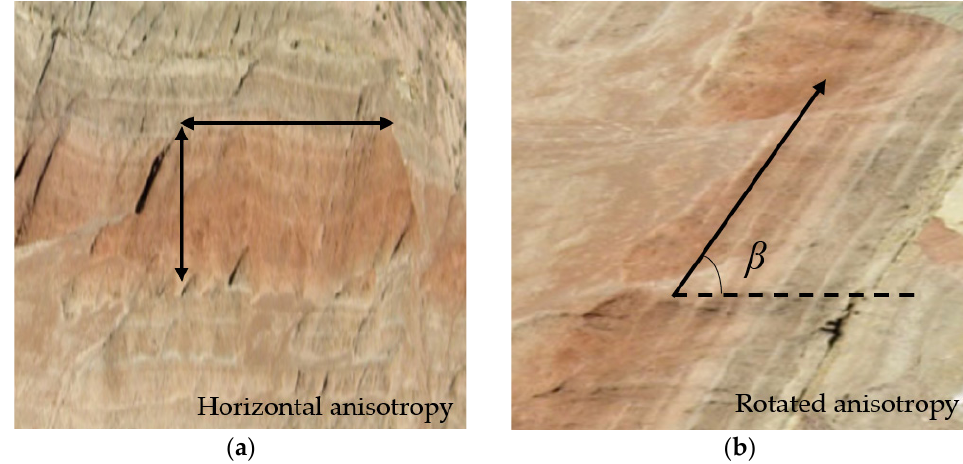
Figure 1. Soil deposition with spatial anisotropy. ( a ) Horizontal anisotropy; ( b ) Rotated anisotropy.